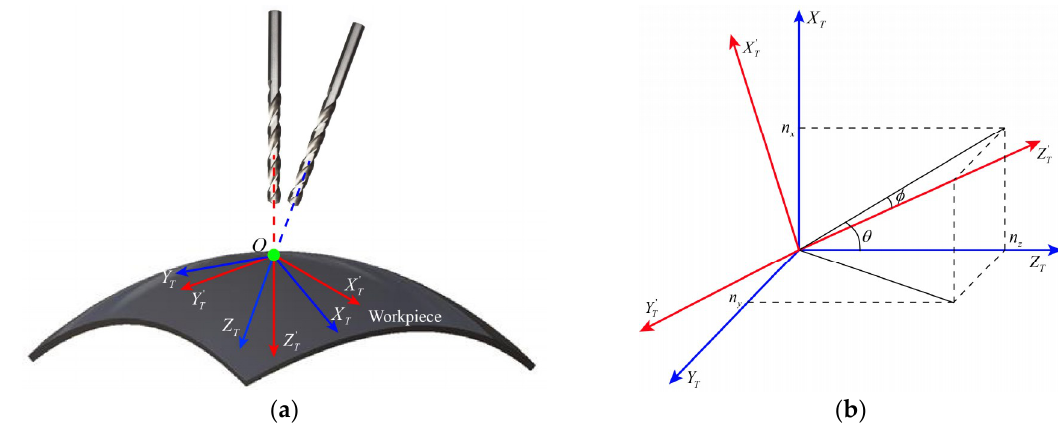
Figure 6. ( a ) The diagram of attitude adjustment. ( b ) Surface normal vector decomposition in